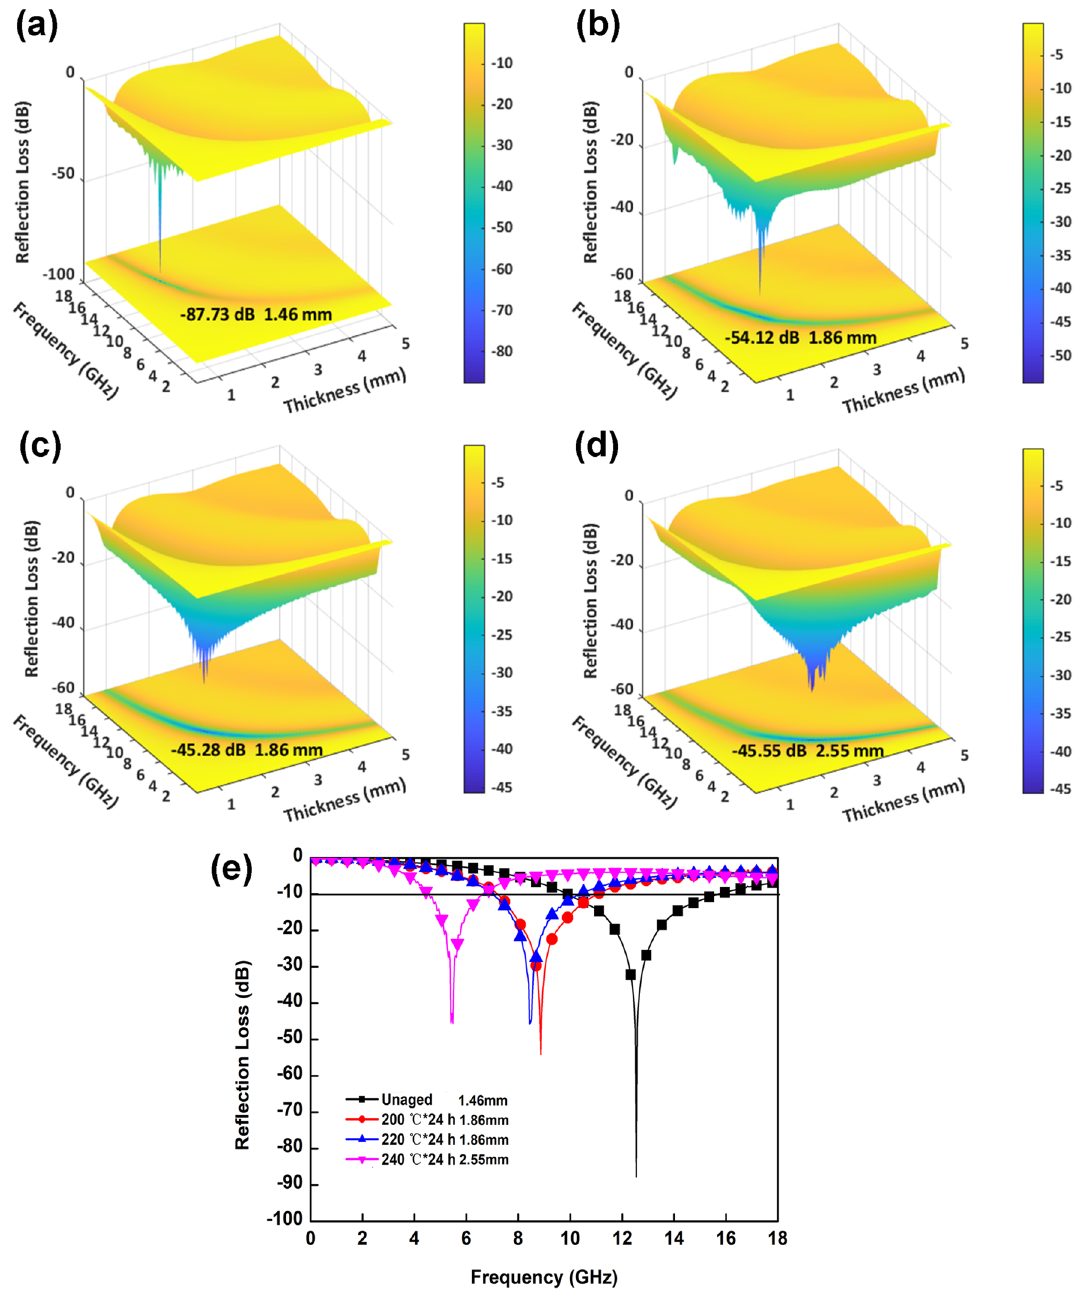
Figure 7. RL of the composites aged at different temperatures: unaged ( a ), 200 °C × 24 h ( b ), 220 °C × 24 h ( c ), and 240 °C × 24 h ( d ) and the influence of the frequency on the RL min ( e